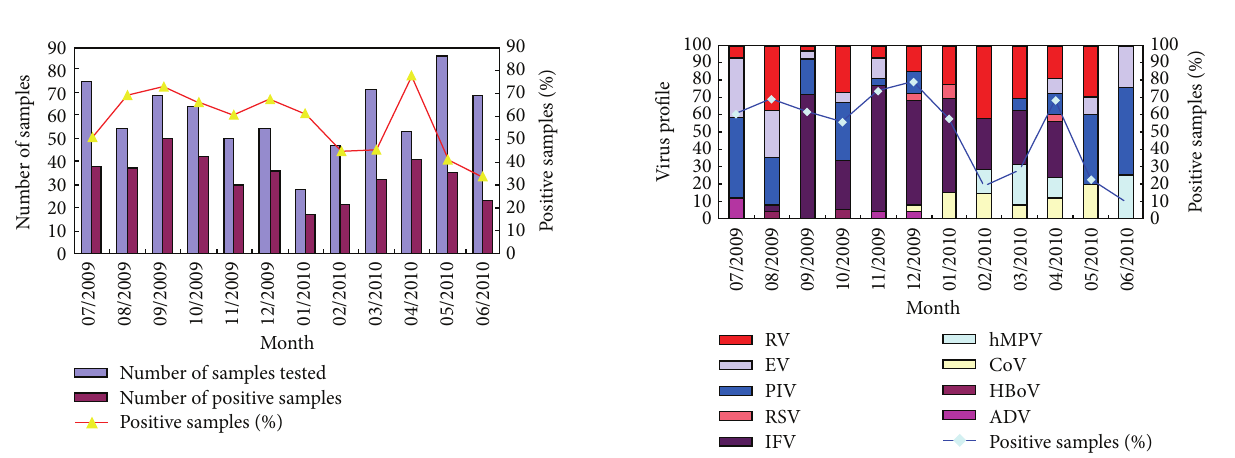
Figure 1: Number of recruited patients and the numbers of positive samples for viral infections. Figure 2: Number of positive results for various viruses in patients with acute upper respiratory tract infections.